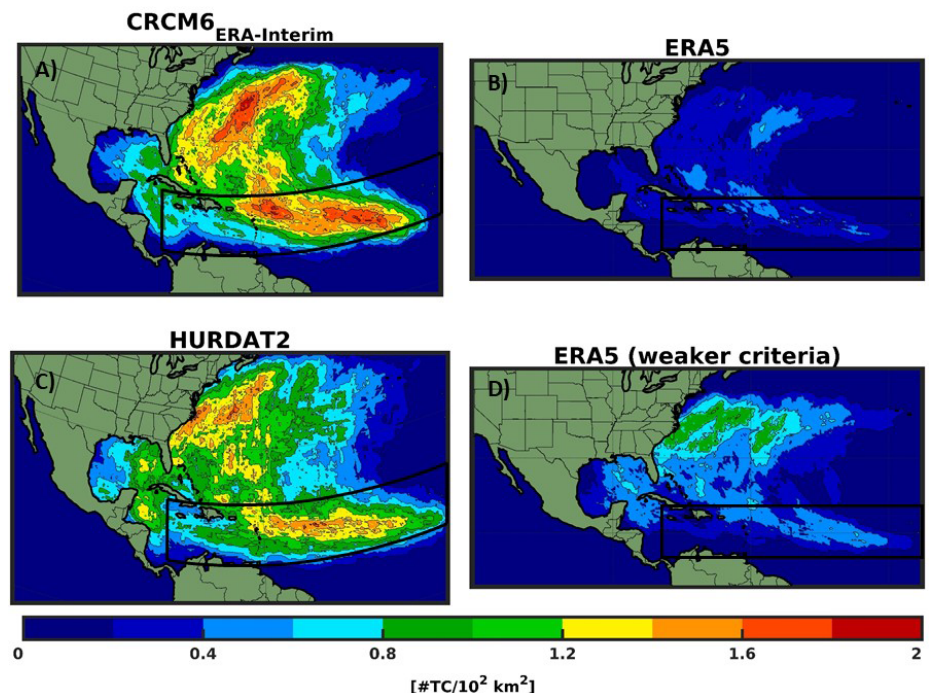
Figure A1. JJASON climatology (1980–2009) of (a) track density for the CRCM6 ERA-Interim-driven experiment at 0.22 ◦ ; (b) ERA5 reanalysis data at 0.25 ◦ ; (c) observed TCs from the HURDAT database at 0.11 ◦ and (d) ERA5 reanalysis data using weaker detection criteria at 0.25 ◦ . The black box shows the present-day MDR. Note that the ERA5 figures are projected over a Mercator grid while the other two figures use the equidistant cylindrical projection. The contour lines follow the color-bar scale.